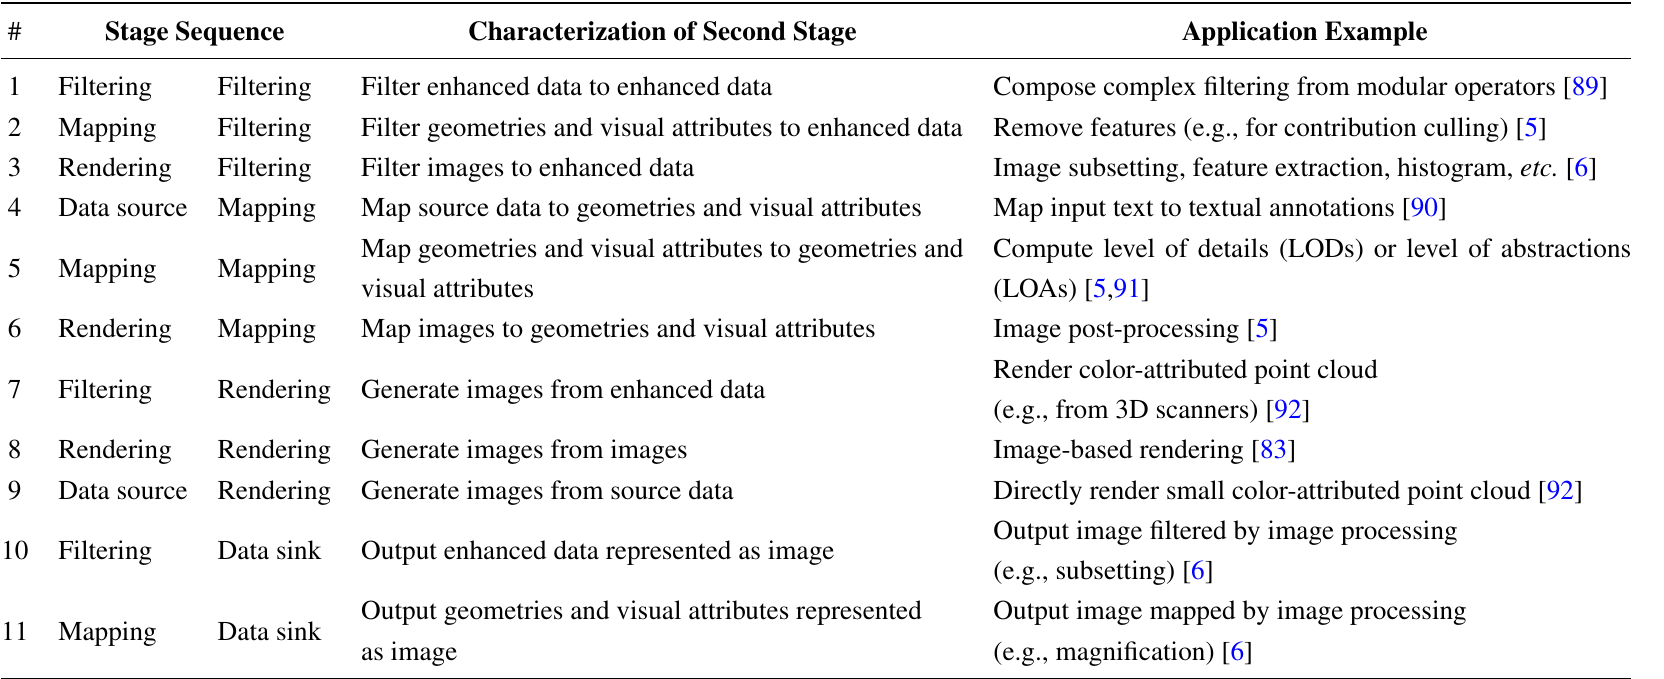
Table 1. Two-stage sequence fragments of visualization pipelines with characterizations and application examples that cannot be expressed using the traditional visualization pipeline model, but instead using the proposed generalized visualization pipeline